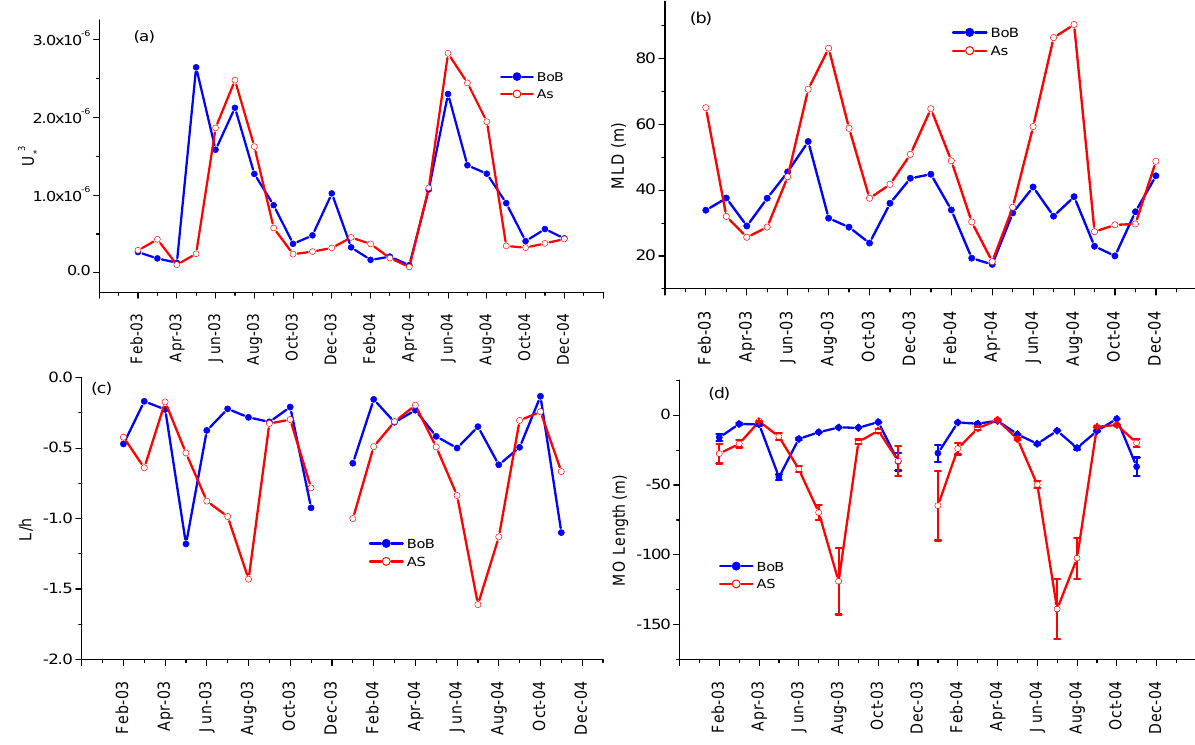
Fig. 3. Time Series of (a) ustar cubed (b) MLD( h ) (c) ratio of M-O length to mixed layer depth ( L/h ) (d) M-O length ( L ) with error bars.